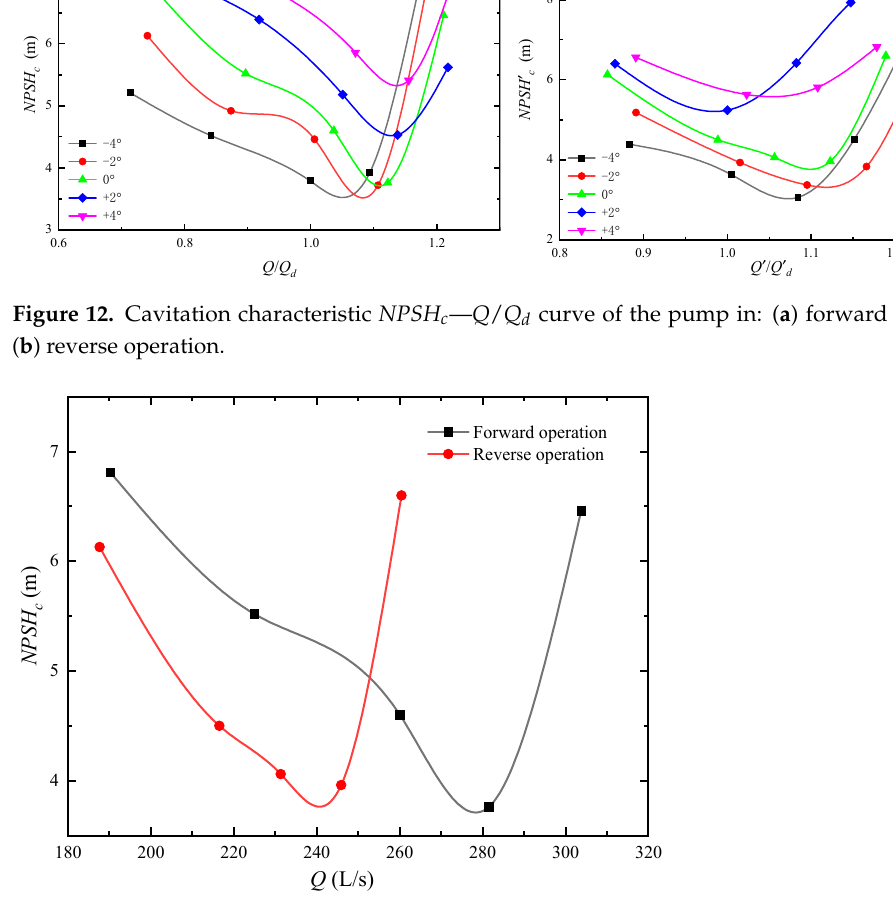
Figure 13. Cavitation characteristic NPSHc − Q curve of the pump at blade angle β = 0 ◦